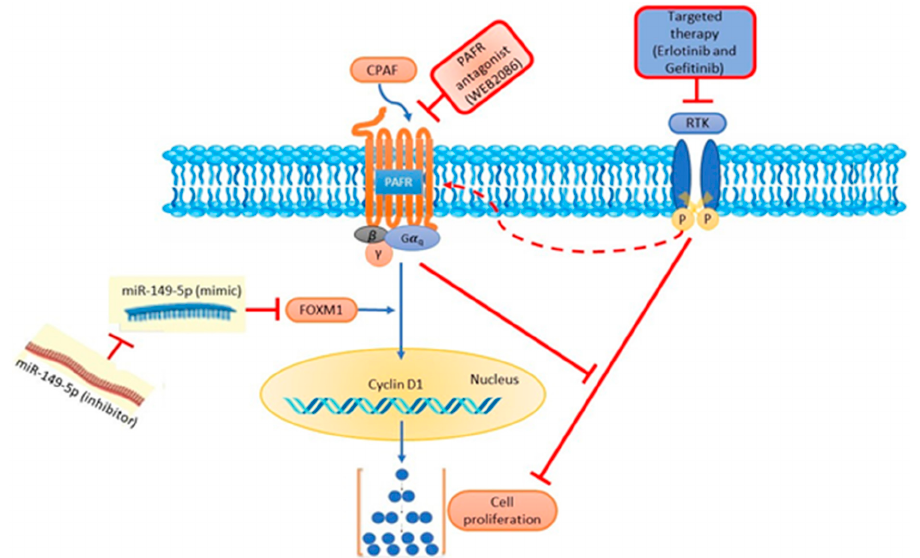
Figure 9. Schematic representation of PAFR- and miR-149-5p-mediated effects on the growth of NSCLC cells and/or cytotoxic responses of targeted therapies. In this model, the PAFR activation (via CPAF) induces an increased proliferation of NSCLC cells by an upregulation of cyclin D1 and FOXM1, in a process which is blocked by the overexpression of miR-149-5p and PAFR antagonist. Importantly, miR-149-5p mimic-mediated effects are blocked by the miR-149-5p-specific inhibitor, comparable to the PAFR activation-induced effects, indicating their crosstalk and antagonizing functions. Targeted therapies decrease the proliferation of NSCLC cells in a process blocked by PAFR